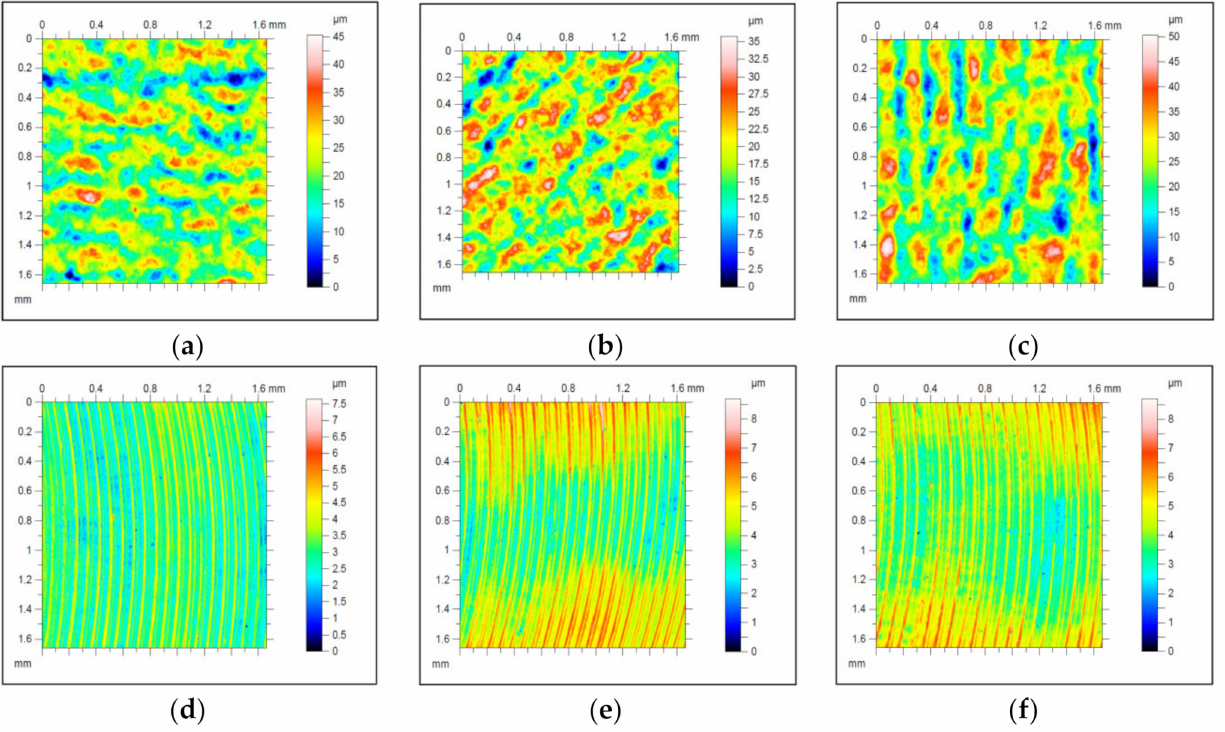
Figure 3. Representative images of surface topographies prior to processing built at ( a ) 0 ◦ , ( b ) 45 ◦ , and ( c ) 90 ◦ ; and after processing at ( d ) 0 ◦ , ( e ) 45 ◦ , and ( f ) 90 ◦